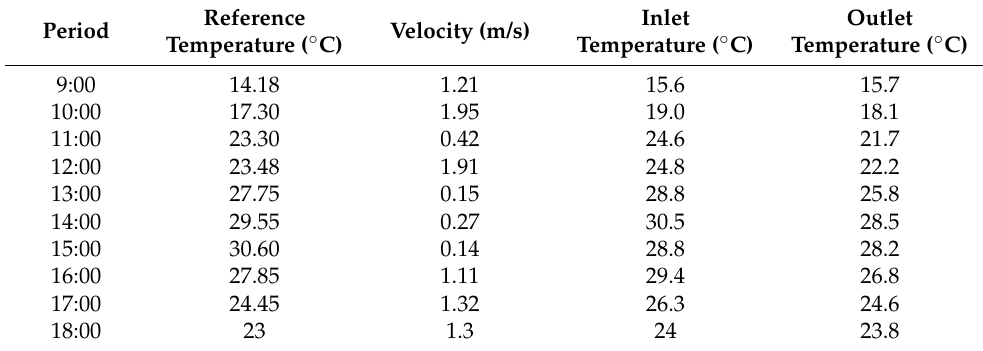
Table 5. Boundary conditions for ventilation calculation.